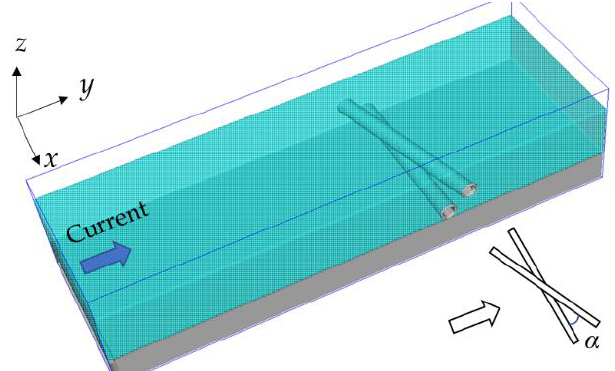
Figure 5. Sketch of the 3D numerical model for scour below two crossing pipelines. Figure 6. Sketch of the 3D numerical model for scour below two crossing